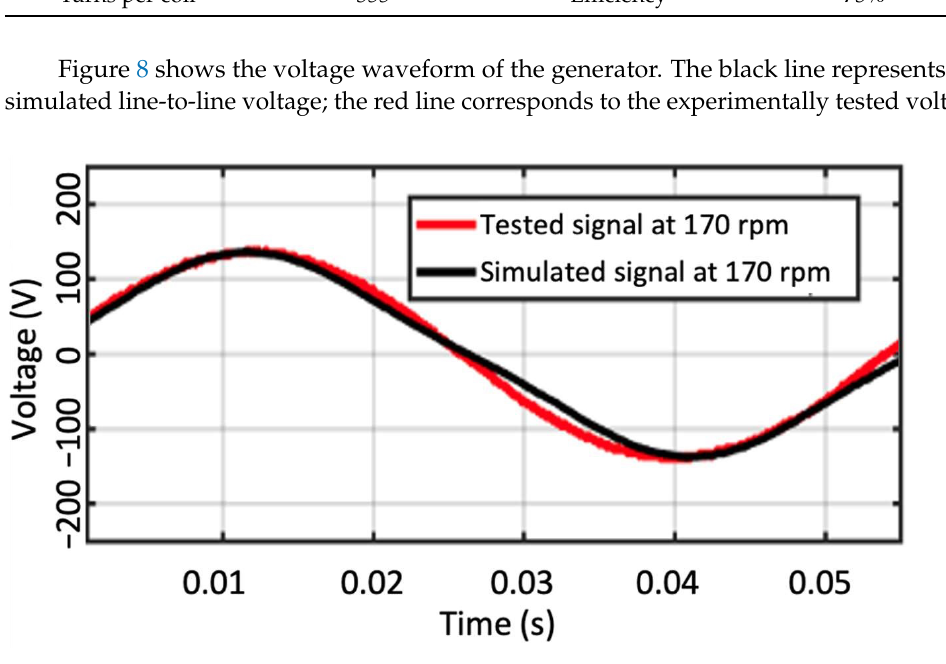
Figure 9. Simulation results under load conditions. 2.4. A Short List of SWTs Below 5 kW and Their Main Characteristics for Grid Connection Capacity A short list of SWT grid-connected models was selected within the low-power range (less than 5 kW). For these models, the main characteristics relevant to this study were identified, when available. The results are shown in Table 2.